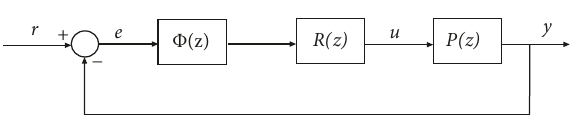
Figure 2: RC as a feedback problem